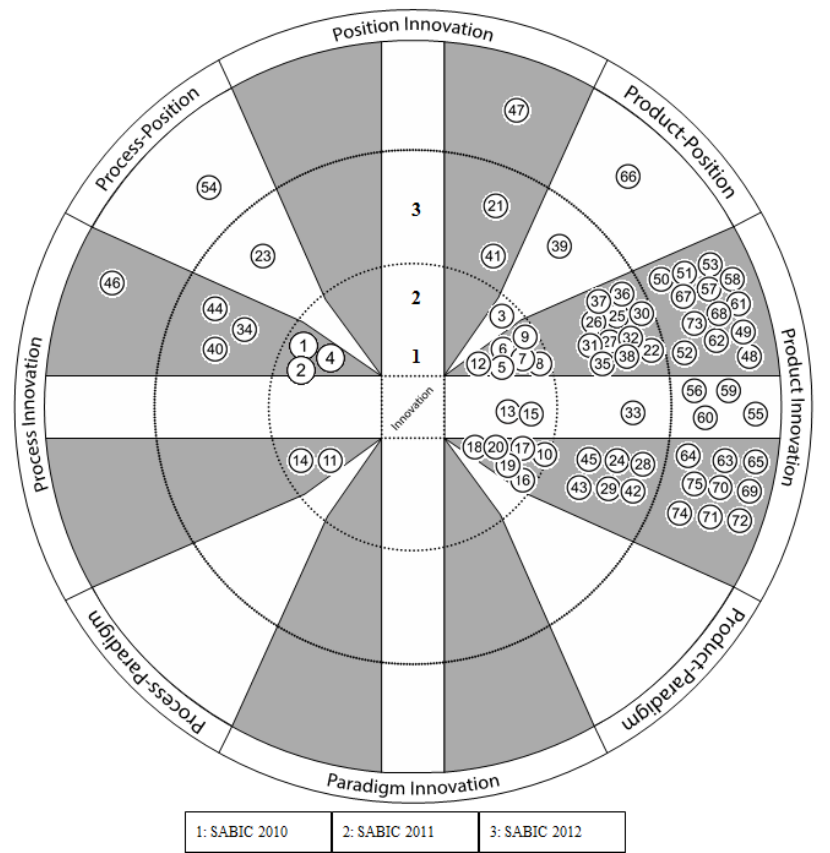
Fig. 4. Mapping Innovation of SABIC from 2010 to 2012 Using 10Ps Benchmarking Innovation Mapping